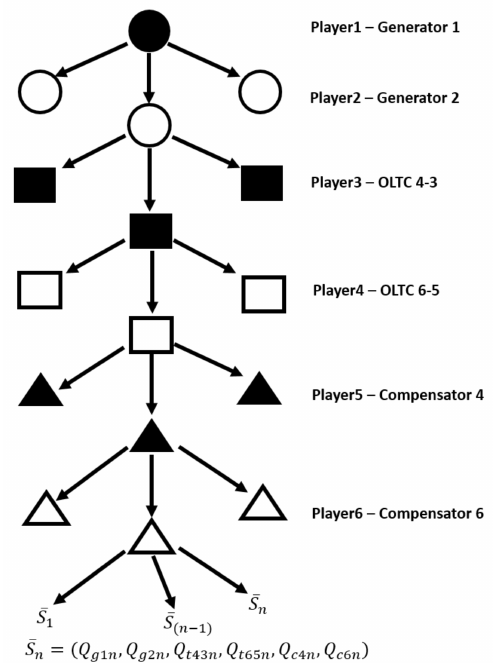
Figure 2. Non-cooperative extensive form game model (with perfect